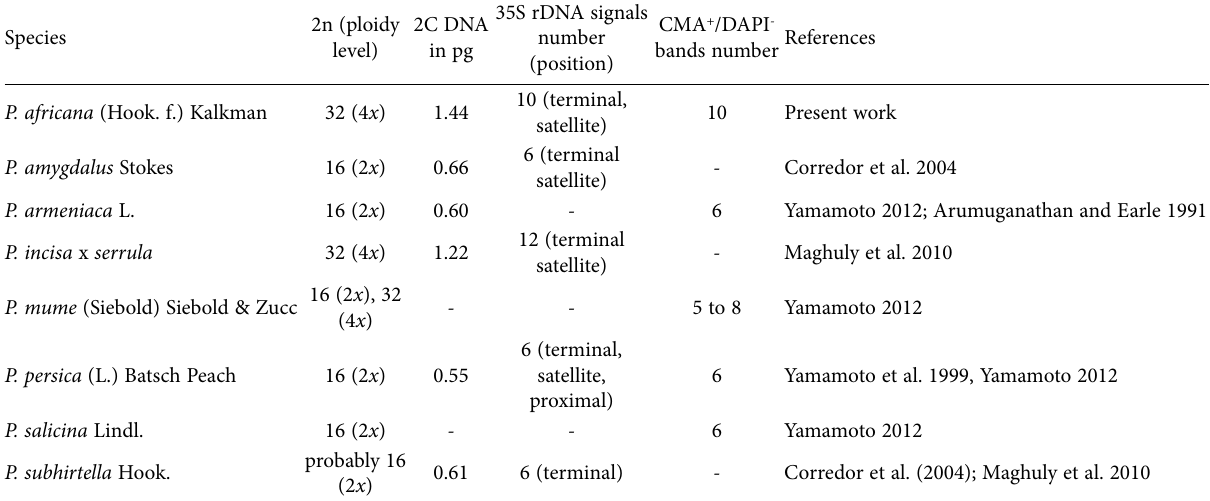
Table 1. Prunus species for which some molecular cytogenetic data are available. Comparison with our results of P. africana .